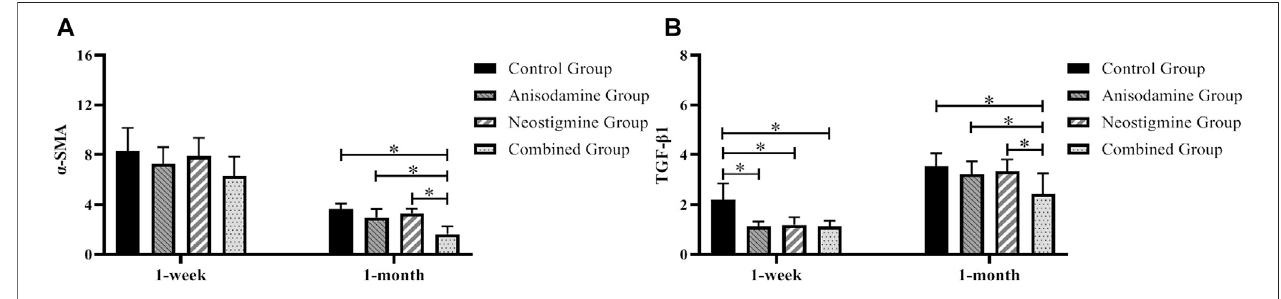
FIGURE9| Changesoftheexpressionlevelsof α -SMAandTGF- β 1inratsatdifferenttimepointsaftertheRCJSprocedure(*referstothecomparisonbetweenthe two groups, p < 0.05). Comparison of (A) α -SMA gene expression and (B) TGF- β 1 gene expression among different groups of rats at different time points.